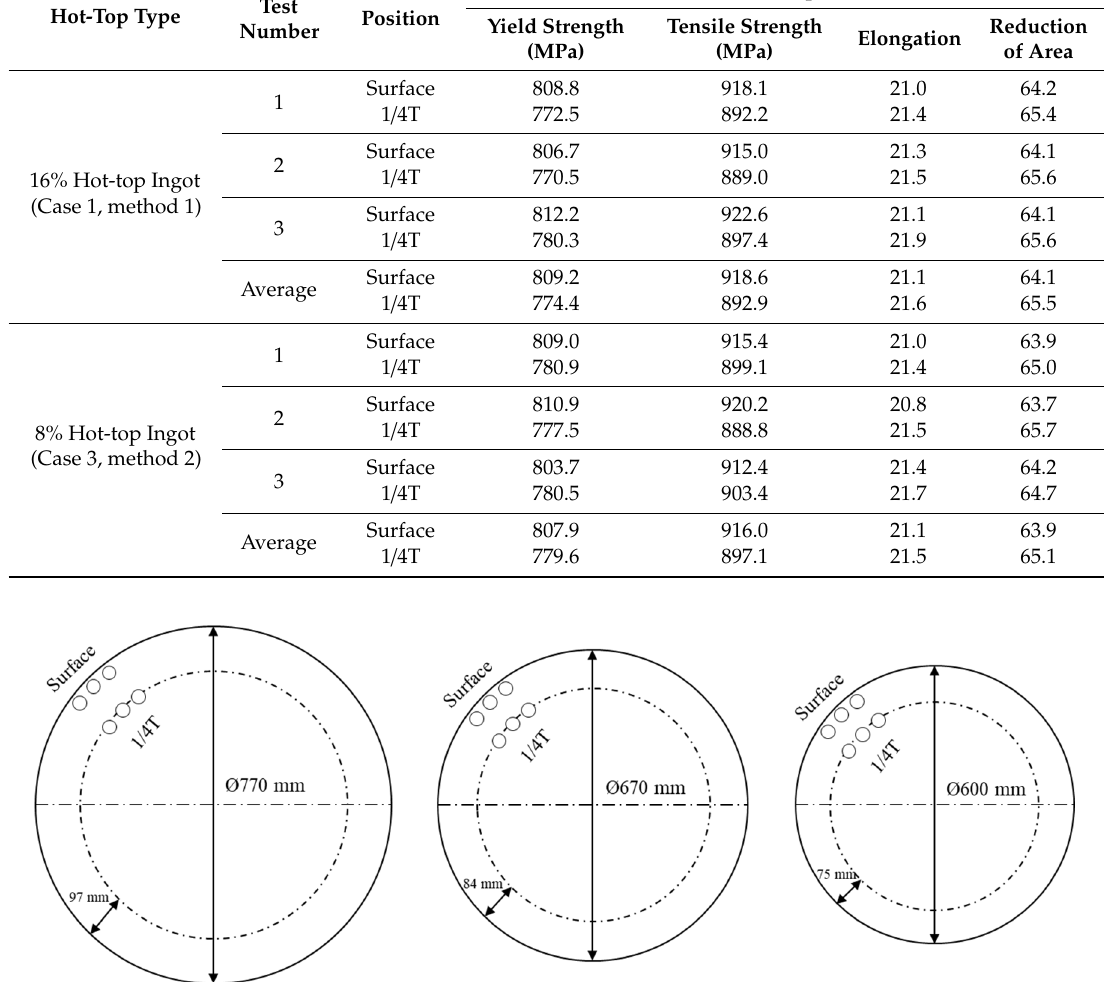
Figure 14. Test specimen extraction positions.